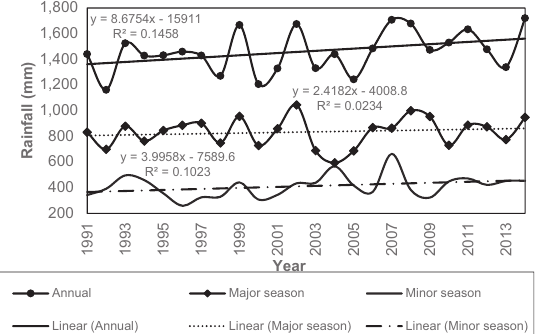
Figure 4. Trend of the